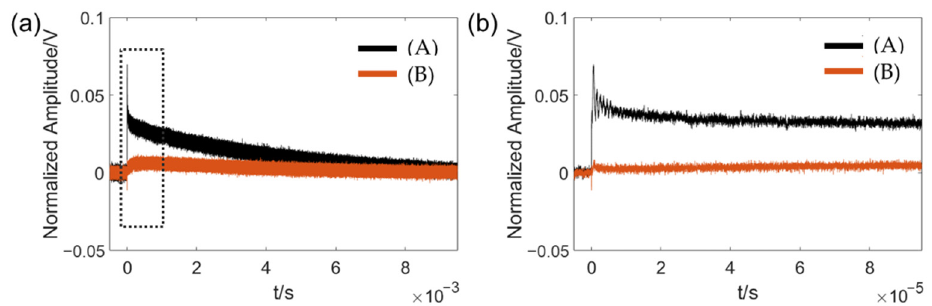
Figure 11. Temporal experimental time-domain results between agarose gel and silicon under different pulse laser intensities. The incident pulse energy in (B) was half that of (A); ( b ) the zoomed curve from ( a ), with a horizontal range of 100 µs.